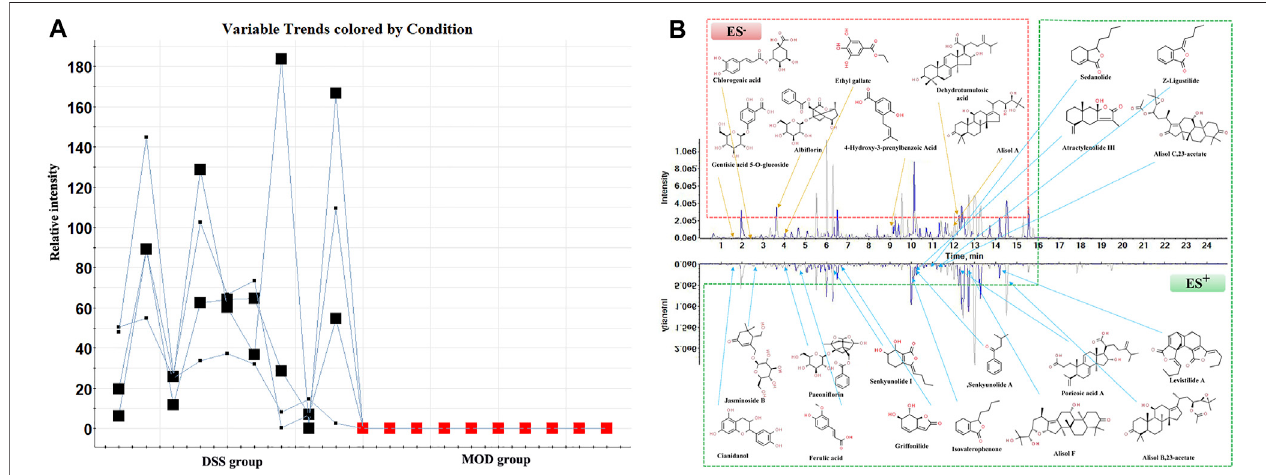
FIGURE 4 | Analysis of the constituents absorbed into the blood from DSS. (A) The trend plot of relative intensity of the candidate variables in the MOD and DSS groups, (B) UPLC-MS chromatograms and chemical structures of the constituents absorbed into the blood from DSS in the ESI + and ESI −